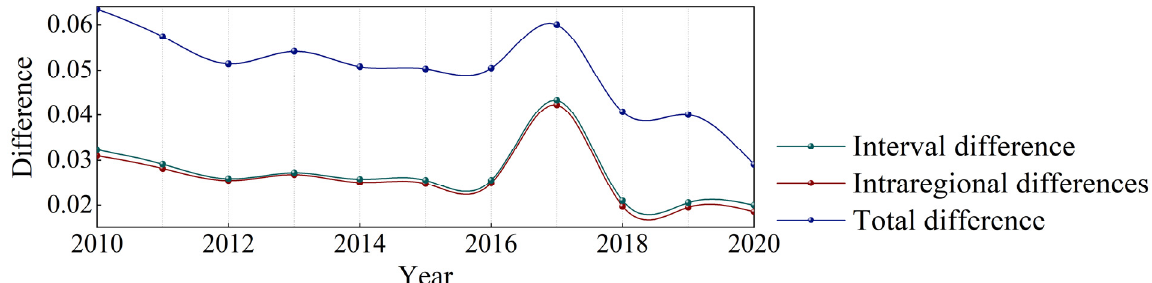
Figure 3. Evolution and decomposition of wheat yield differences in the HHH region.